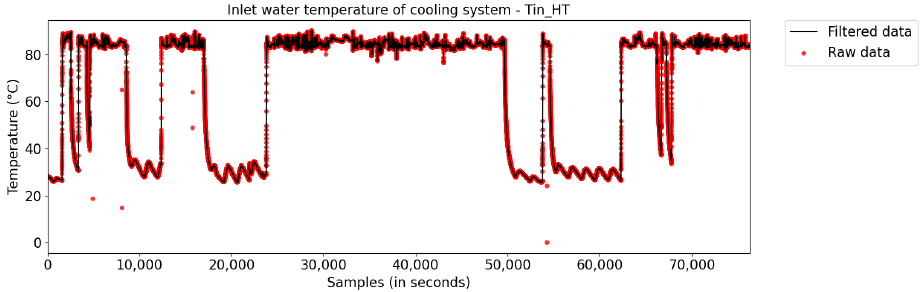
Figure 5. Pre-processing of the input temperature variable